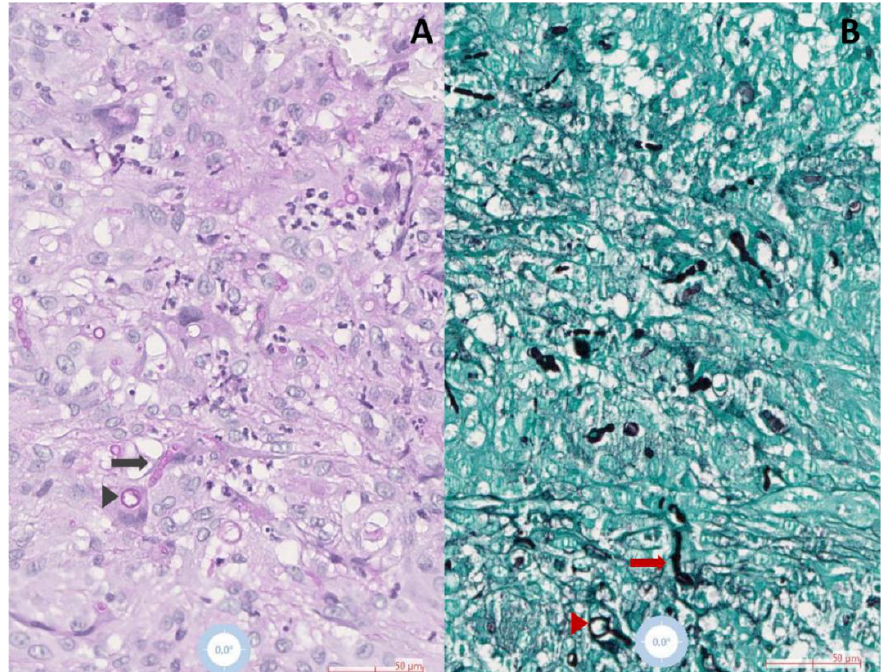
Figure 1. Histopathological examination of skin biopsies demonstrating hyphal (arrows) and yeast structures (arrowheads) surrounded by epithelioid, multinuclear giant histiocytes and neutrophils in ( A ) Periodic acid – Schiff (black arrow and arrowhead), and ( B ) Grocott-Gomori (red arrow and arrowhead) stained slides, observed in 20× magnification.